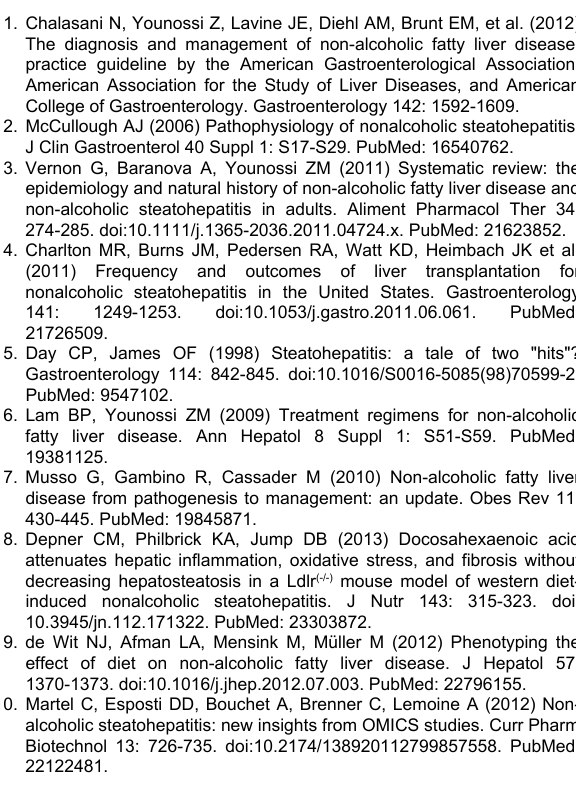
and fractionated lipids were separated by thin layer chromatography as described in Methods. After separation, lipids were stained with iodine and photographed. Authentic standards (non-esterified fatty acid (NEFA), triglycerides, diacylglycerol phosphatidylcholine (polar lipid), cholesterol and cholesterol esters) were run in adjacent lanes. The chromatogram has three representative hepatic extracts for total lipids, NEFA, polar lipids and neutral lipids. Figure S2. Principle component analysis. Separation of groups by principle component analysis (http:// www.metaboanalyst.ca). Known metabolites in the 5 groups [chow (CH); WD + O (WDO); WDE (WD + E); WD + D (WDD); WD + E +D (WDC) were included in the analysis. The explained variances are shown in brackets. The numbers in each bracket/group represents animal identification numbers.